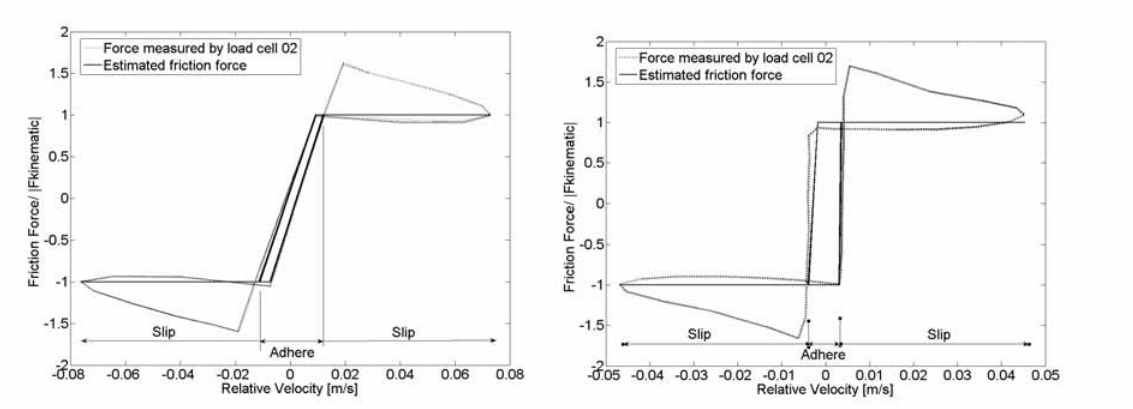
Fig. 12. Normalized global and estimated force vs. relative velocity: (a) at 10 Hz excitation and (b) at 18 Hz excitation. normal force applied at the bronze pads. If the normal force signal is measured, its frequency spectrum can be used to calculate the friction